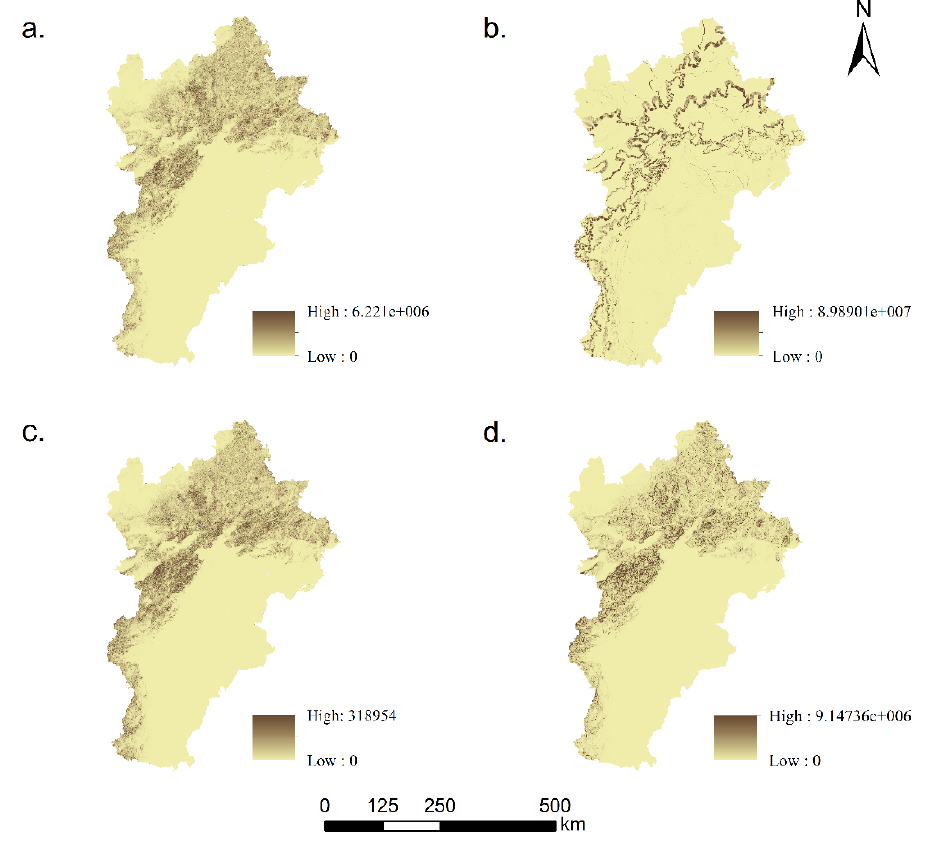
Figure 4. Distribution of soil conservation under different scenarios. ( a ) 2015; ( b ) conservation scenario; ( c ) development scenario; ( d ) natural scenario.